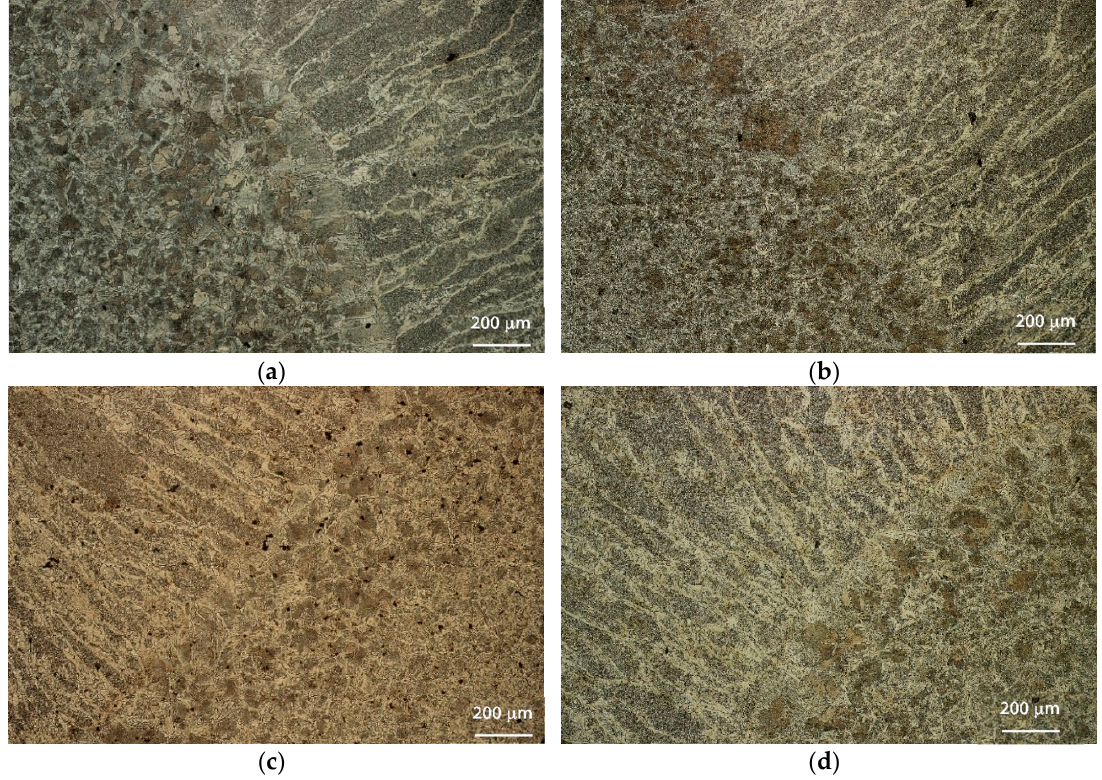
Figure 6. Comparative metallurgical cross-sections through the fusion zone and heat-affected zone of S235 steel, at different vibration frequencies: (a) No vibration, (b) 12.8 Hz, (c) 58.4 Hz, (d) 60 Hz.